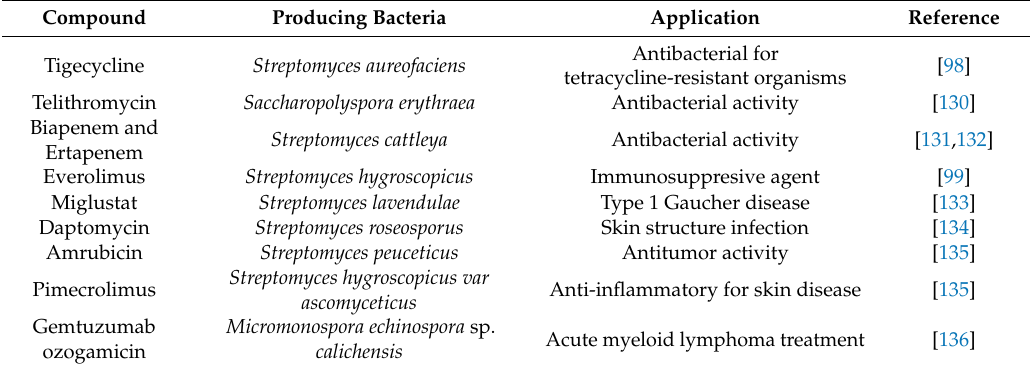
Table 2. Some FDA-approved drugs from